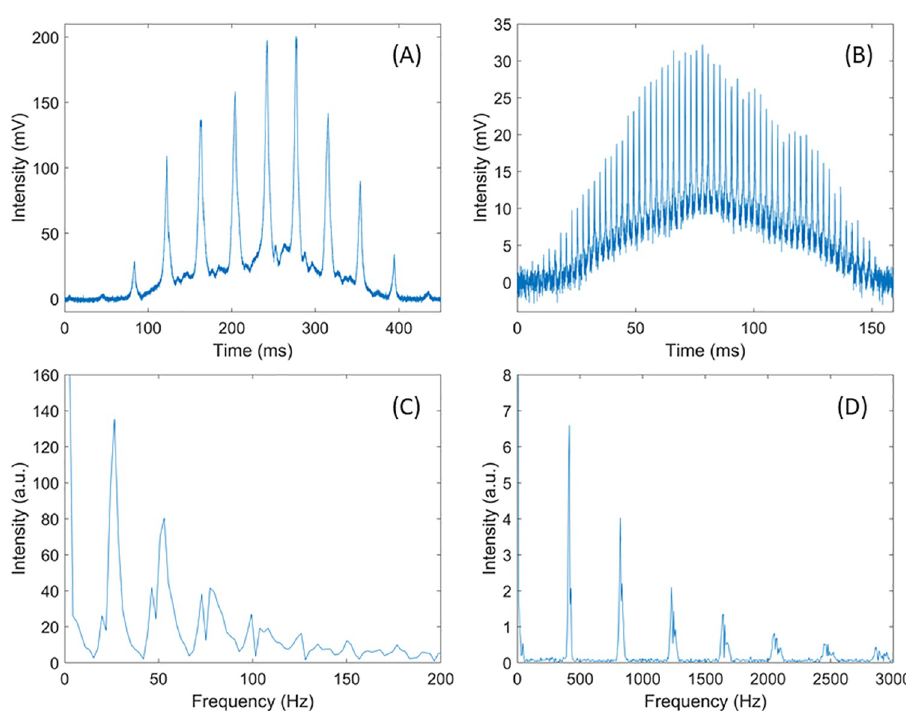
Fig 3. Examples of insect signals as they transit through the laser beam of the ESOS system (A and B) along with their frequency analysis through fast Fourier transform (C and D).